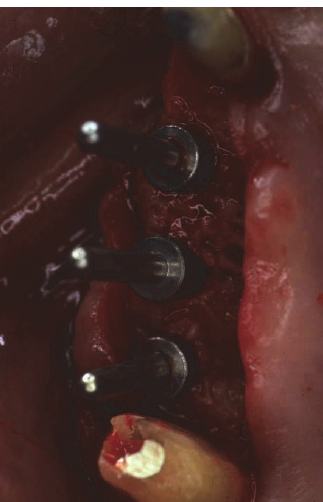
Figure 22: Radiographic postoperative control: coincidence of radiopaque landmarks embedded in the temporary crowns and the implant position of 14, 15, and